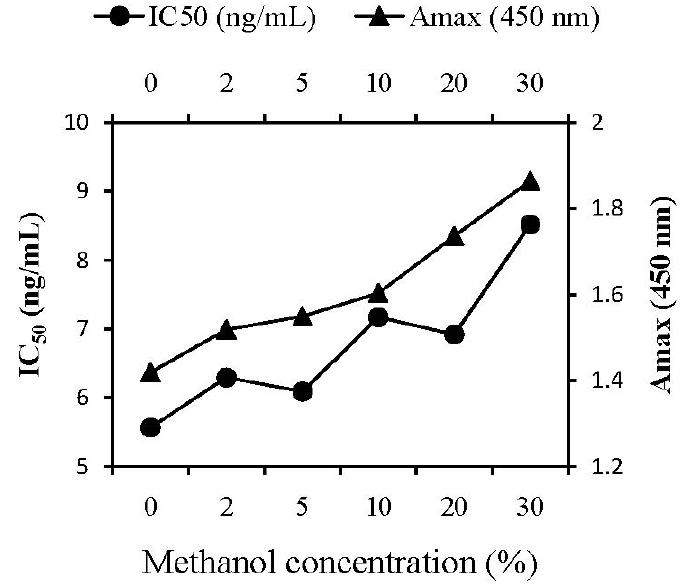
Figure 2. Effect of methanol concentration on ELISA performance. For the competition step, standards were prepared in PB (pH 6.5) containing different concentration of methanol and the Mab was diluted in PB (pH 6.5), incubation temperature was 37 °C.